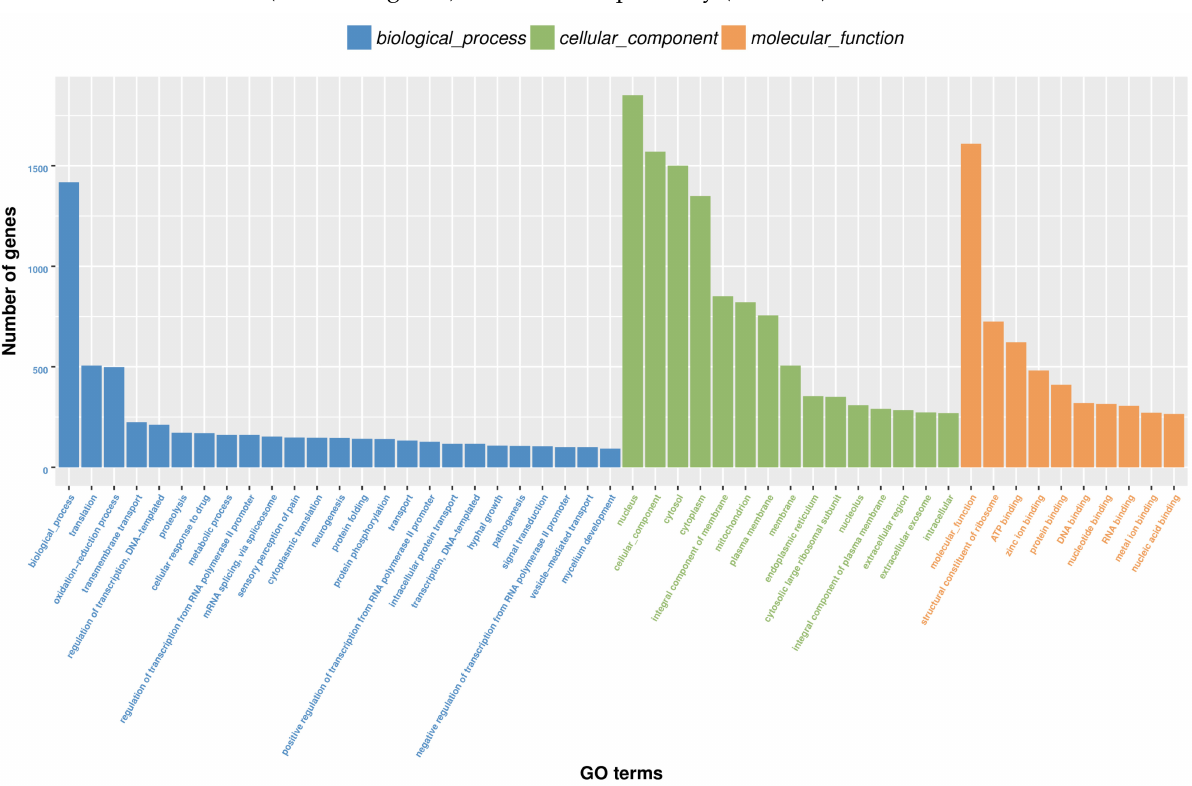
Figure 2. Gene ontology (GO) classification of M. sanborni